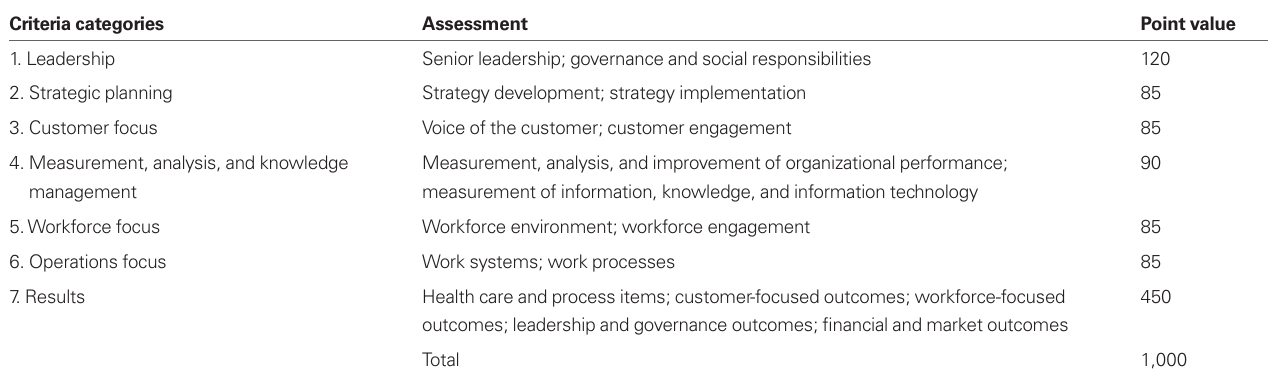
Table 1 | Health care criteria.